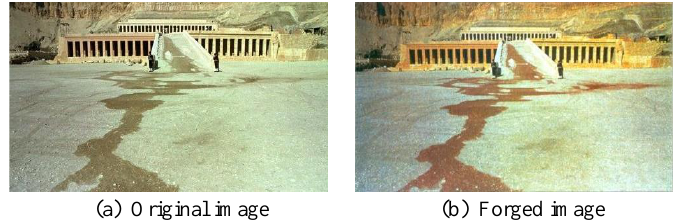
Figure 5. The German-language daily tabloid, Blick, forged the flooding water to blood red, and distributed the falsified image to news